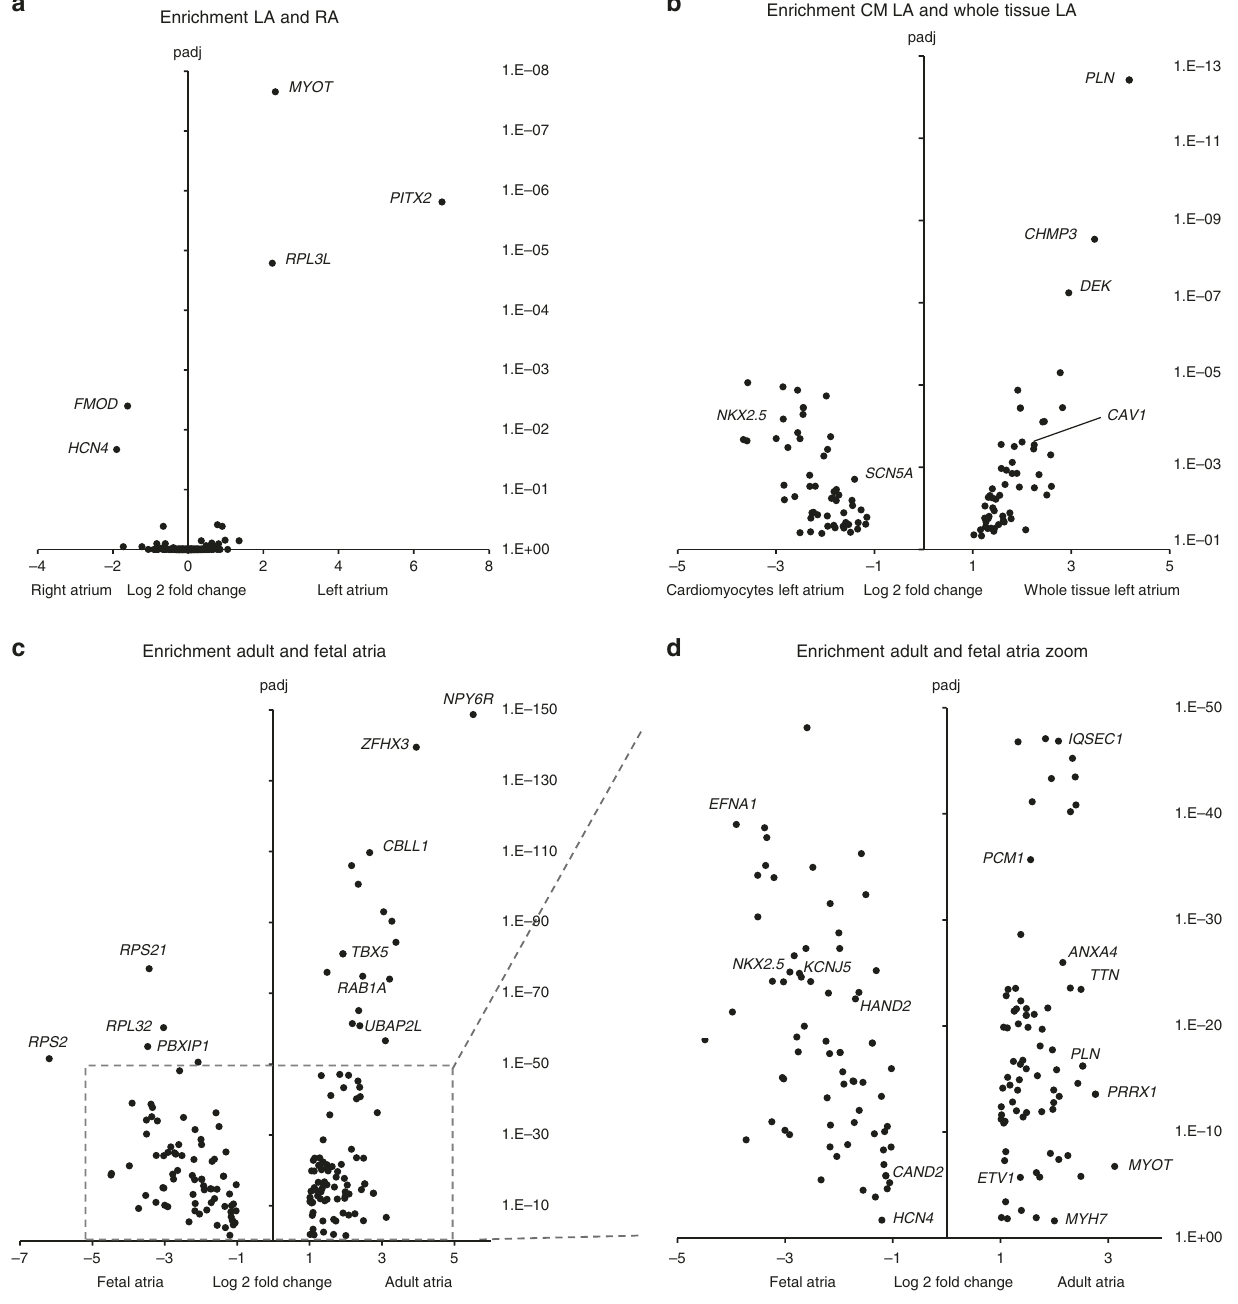
Fig. 4 RNA-seq enrichment of AF target genes. Enrichment of expression of AF target genes (score > 11, − 1 > L2FC > 1, padj < 0.05), comparing a enrichment of expression of LA and RA, b CM and whole tissue, c fetal and adult atria, and d zoom of fetal and adult atria. p -values are calculated with DESeq2 package (based on Wald-test) and corrected for multiple testing using false discovery rate method of Benjamini-Hochberg. Source data of all panels are provided as Source Data fi les. L2FC Log2-fold change, p adj adjusted p -value, CM cardiomyocyte, LA left atria, RA right